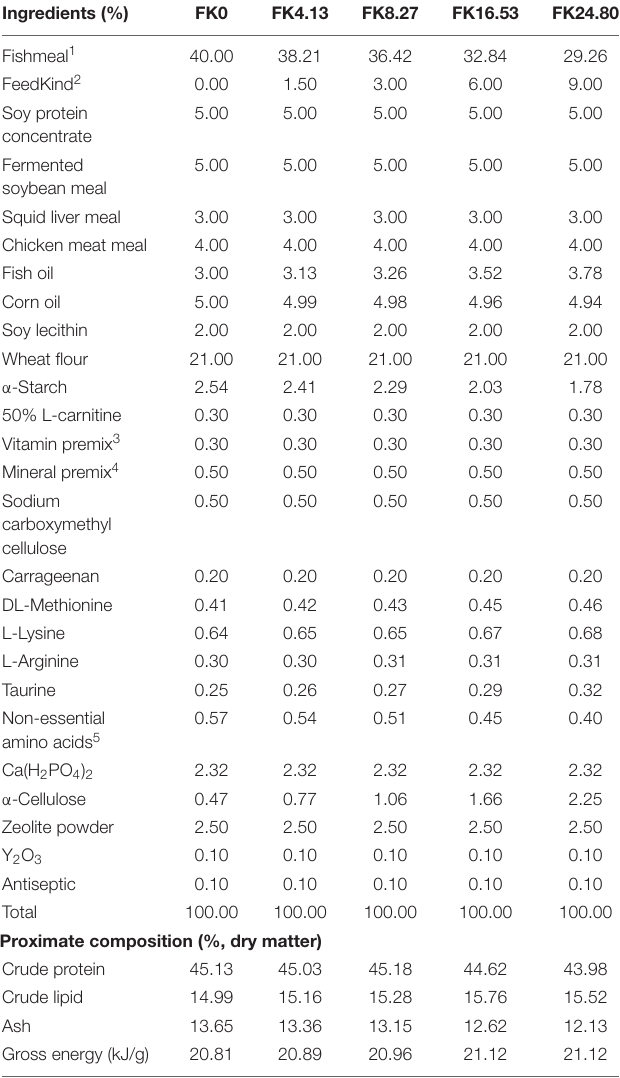
TABLE 2 | Feed formula and proximate composition of the experimental